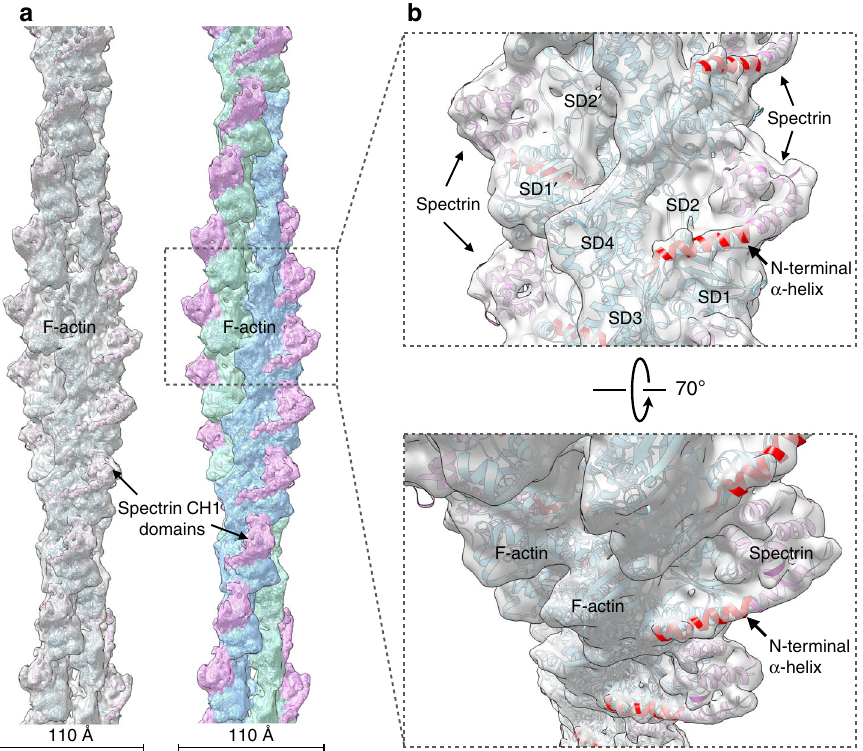
Fig. 1 Cryo-EM map and model of L253P β -III-spectrin ABD bound to actin. a The map (left, gray transparent surface) has been fi t with a model for actin (cyan) and the β -III-spectrin ABD (magenta). On the right, the surface of the reconstruction has been color coded for the two actin strands (blue and green) and the β -III-spectrin ABD (magenta). b Close-up view of a showing that the CH1 domain has an additional N-terminal helix (red) interacting with F-actin. The actin subdomains (SD1, SD2, SD3, and SD4) have been labeled on one actin subunit, while SD1 ′ and SD2 ′ are labeled on a different